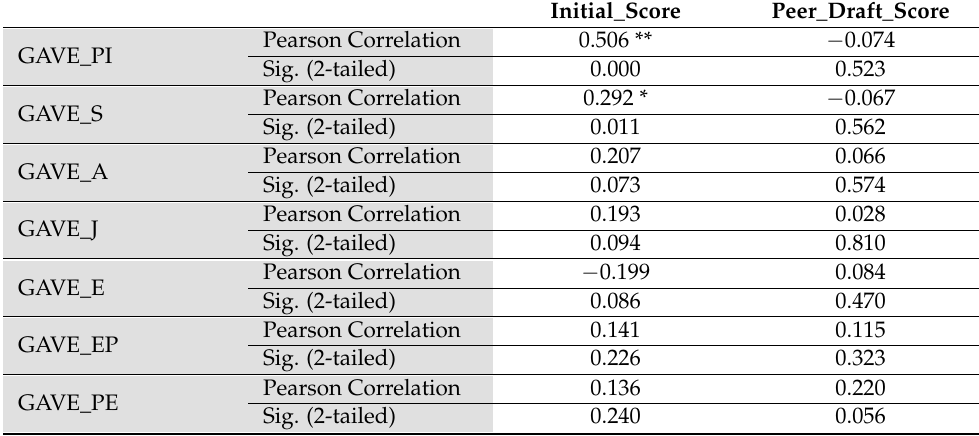
Table 6. Correlation coefficients of predicting variables of Model 2 (types of feedback given) with reviewers’ initial writing ability and quality of the peer